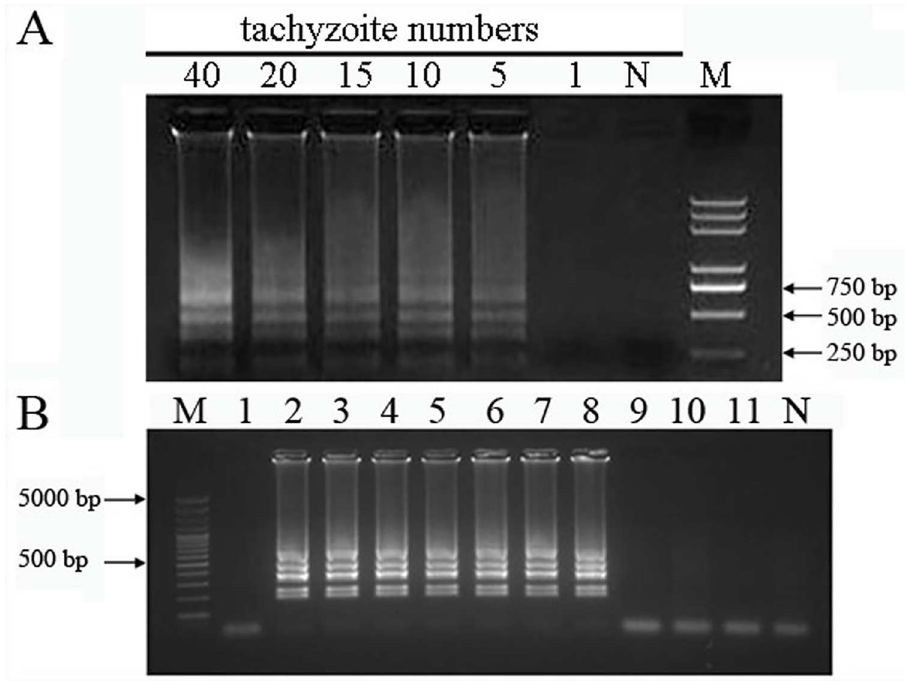
Fig 4. Sensitivity of the LAMP method. LAMP reactions were carried out using genomicDNA from various tachyzoite(s)mixedwith 200 μ L fresh human bloodsample (A) and genomicDNA from single tachyzoite in PBS (B) as the template.